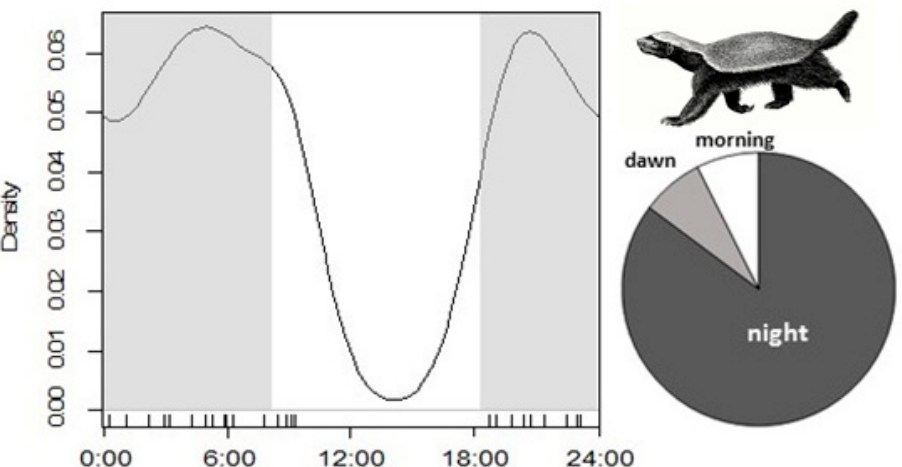
Figure 4. Activity patterns of the honey badger in the Atlantic Sahara. Darkness hours are indicated by the shaded area. Short vertical lines above the x-axis represent the 27 independent records. The pie chart represents these 27 records.